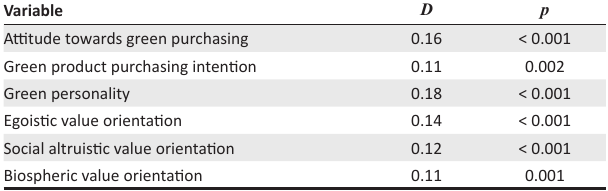
TABLE 2: Kolmogorov-Smirnov test results.